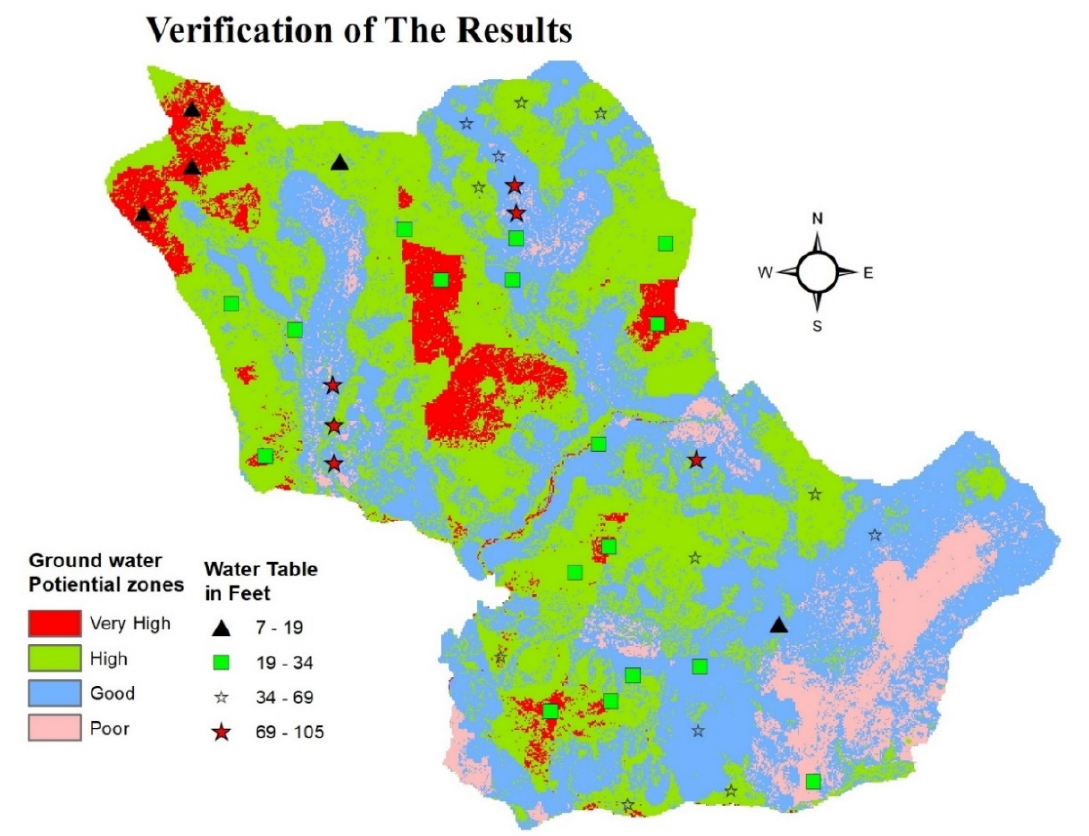
Figure 7. Map shows the groundwater potential zones in Lower Dir, Khyber Pakhtunkhwa, Pakistan overlay by water depth.